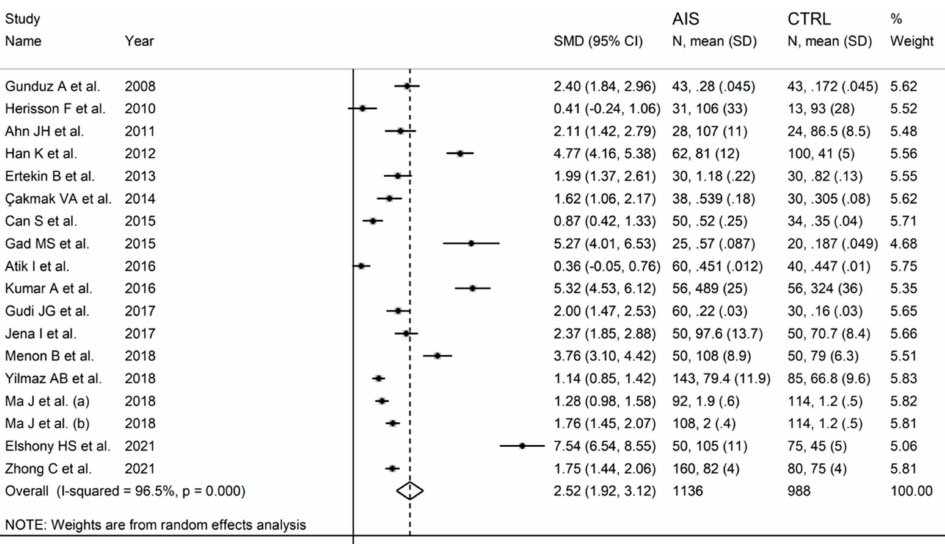
Figure 2. Forest plot of studies examining ischaemia-modified albumin in patients with acute ischaemic stroke and